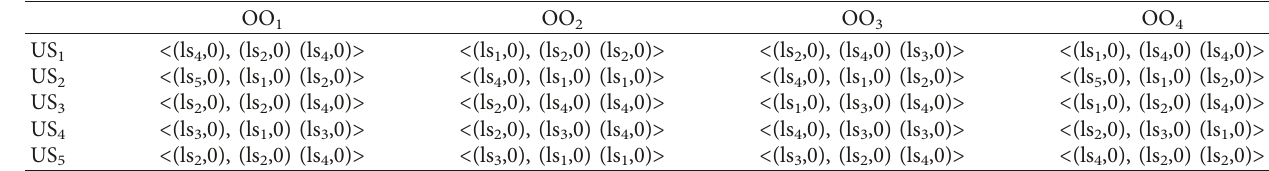
Table 1: 2TLNNs decision values matrix.